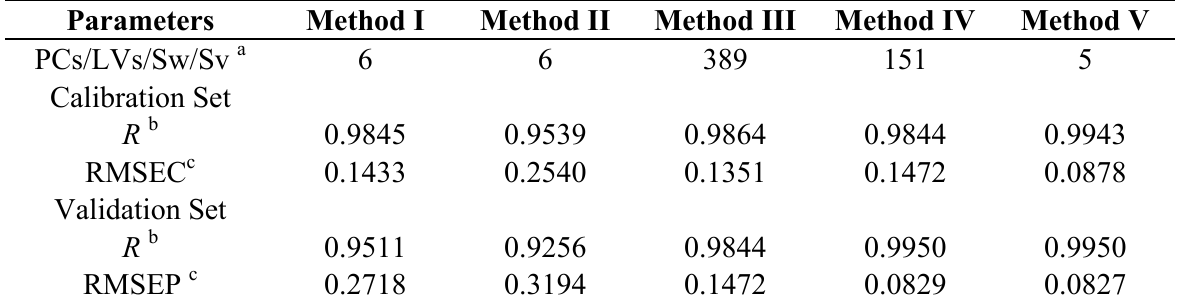
Table 1. The discrimination results of calibration and validation sets by different calibration